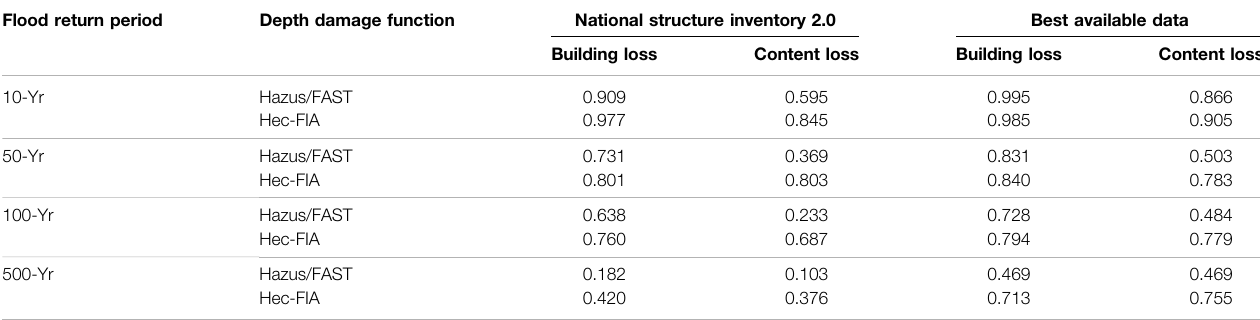
TABLE 7| p -valuesofKruskal-Wallistest (with signi fi cantdifferences at p < 0.05 denoted byan asterisk)on difference ofmediansofbuildingand contentlosses (separately) calculated by Hazus Level 2, FAST, and HEC-FIA, holding return period, building inventory, and depth-damage function constant. Flood return period Depth damage function National structure inventory